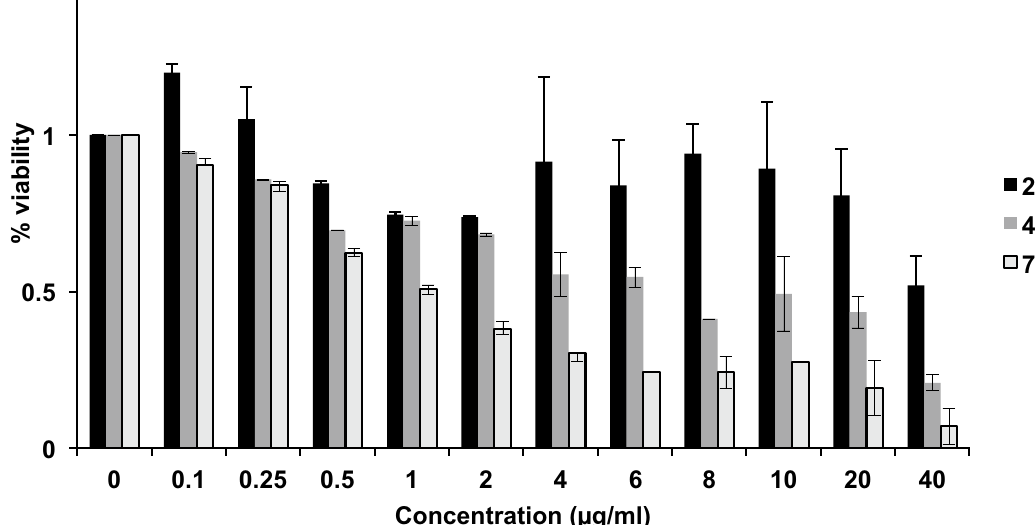
Figure 3. Cell viability analysis of GM1899A cells 24 and 72 h after exposure to different concentrations of MNU. The CellTiter-Blue Cell Viability Assay (Promega) was used. Error bars are standard deviations from 2–3